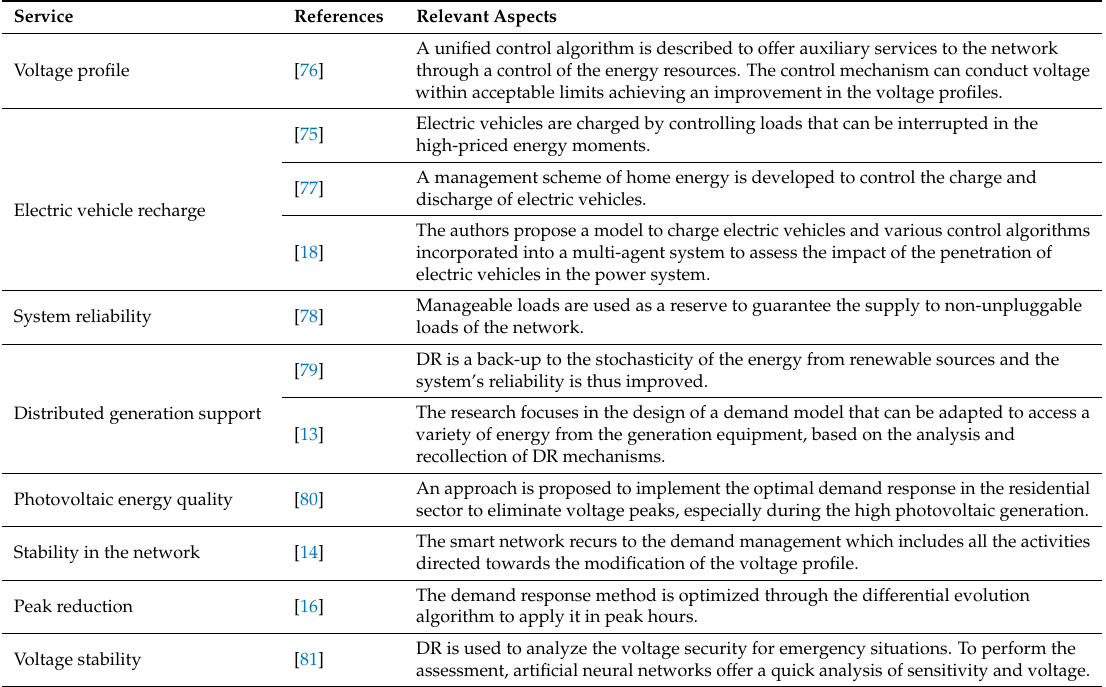
Table 3. Services offered by DR